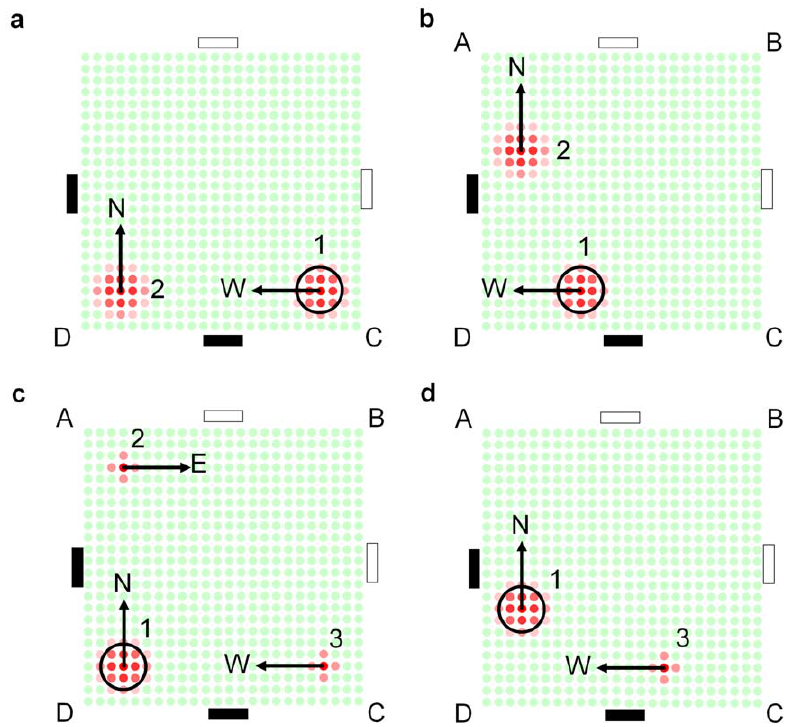
Figure 12. Schematic of the firing profiles of grid cells in the semi-ambiguous corridor arena experiment. The schematic mirrors the actual ensemble cell firing during the robot experiment (Figure 10). The robot’s actual location is shown by a large circle. Because both orientation and location information is stored conjunctively with each grid cell, each cluster of active grid cells is associated with only one orientation estimate. (a–b) As the robot moves west, grid cell firing propagates to represent the movement of the two robot location estimates in two independent directions – one estimate moves west (1), the other moves north (2). (c) When the robot turns at corner D, only one existing location estimate (1) is supported by the sighting of a black cue, and a new location hypothesis (3) is created at C. Because the existing location hypothesis (1) has been further supported by sensory evidence, it is stronger than the newly formed location hypothesis (3). (d) The firing of cells encoding the unsupported location estimate (2) reduces and eventually ceases, leaving the dominant correct location estimate (1) and a secondary location estimate